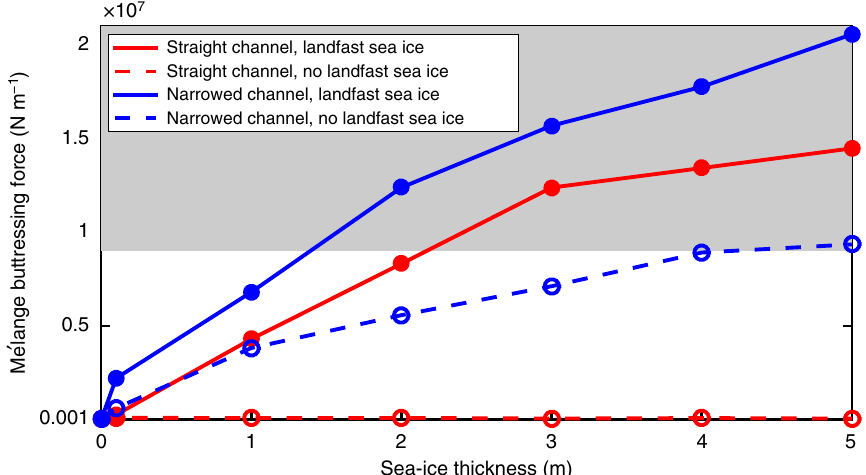
Figure 2 | Me´lange buttressing force on the terminus as a function of sea-ice bond thickness. Buttressing force is obtained by averaging over the terminus width and over 1 month of simulations run to a statistical steady state. Red lines are simulations with a straight channel configuration. Blue lines are simulations with a narrowed channel configuration. Solid lines are simulations that permit sea-ice bonds between me´lange elements and between me´lange elements and channel side elements. Dashed lines are simulations with sea-ice bonds only permitted between me´lange elements. Grey shading indicates the me´lange buttressing force that prevents penetration of fractures near terminus, as estimated in Fig. 9 of Krug et al. 15 and consistent with the Amundson et al. 9 estimates for prevention of iceberg rotation from a terminus at flotation (for y ¼ 1 (cid:2) (Fig. 1b). The channel sides are composed of static elements,